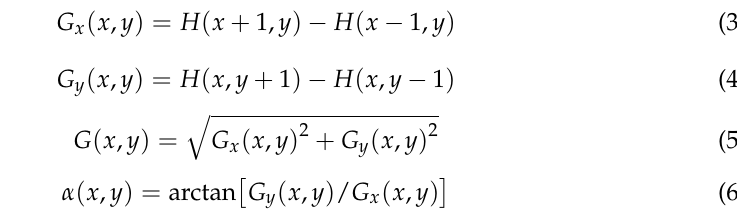
Figure 5. Way to extract the insulator HOG feature.